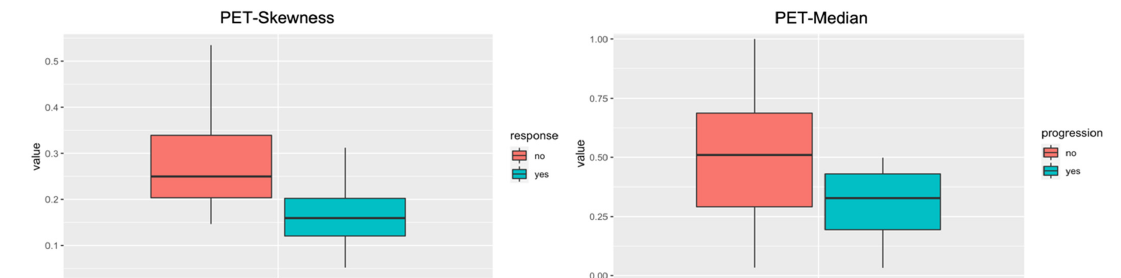
Figure 3. Radiomic features boxplot. The radiomic PET feature PET-Skewness differentiated well between non-responders (red) and responders (green) to immunotherapy after the second follow-up. The Radiomic PET feature PET-Median differentiated well between progression (green) and no-progression (red) overall.